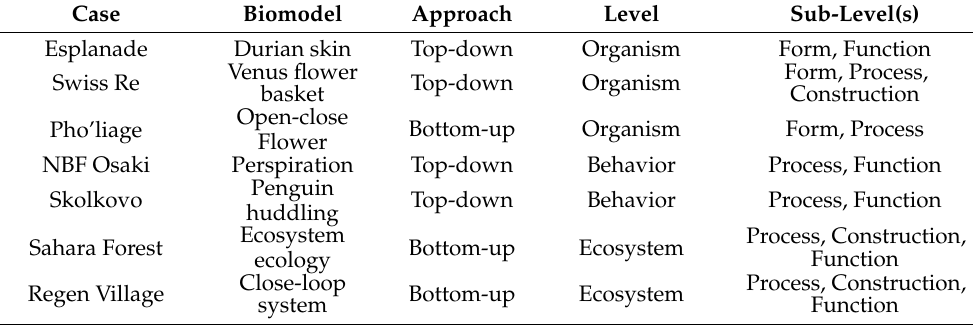
Table 1. Summary of the case studies according to biomimetic design framework.